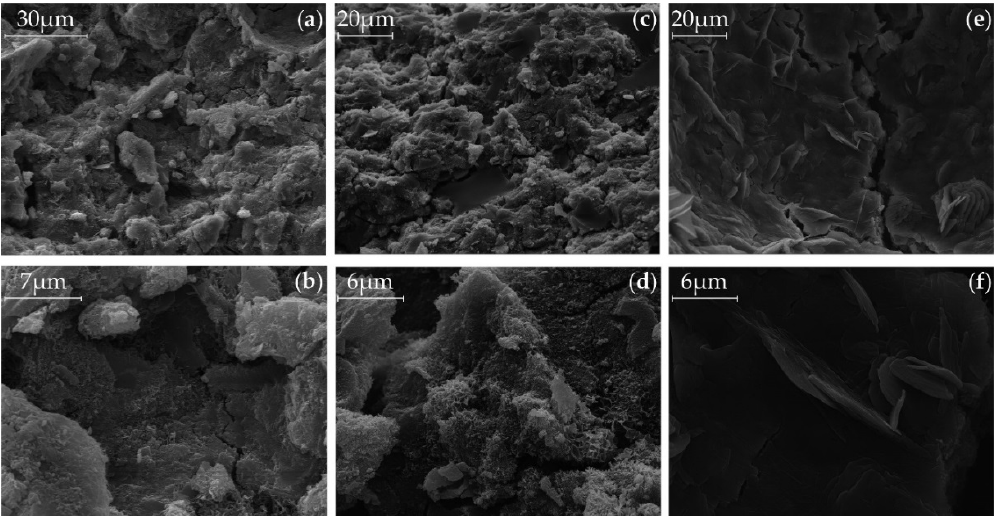
Figure 7. SEM pictures with different magnifications after a hydration period of 28 days, ( a ) and ( b ) of the reference of Ac2, ( c ) and ( d ) of the surface, ( e ) and ( f ) of pore of the reactivated mixtures with Ac2 after 14 days of retardation with 1%R.